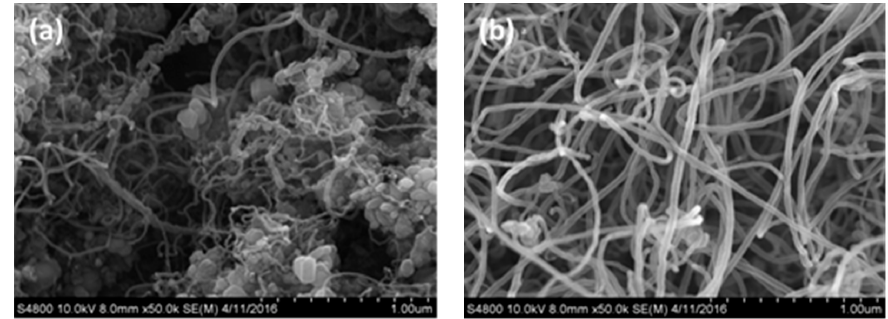
Figure 5. SEM graphs carbon nanotubes generated using argon gas flow velocity of 500 sccm: ( a ) Magnified 5000 times; ( b ) Magnified 50,000 times.